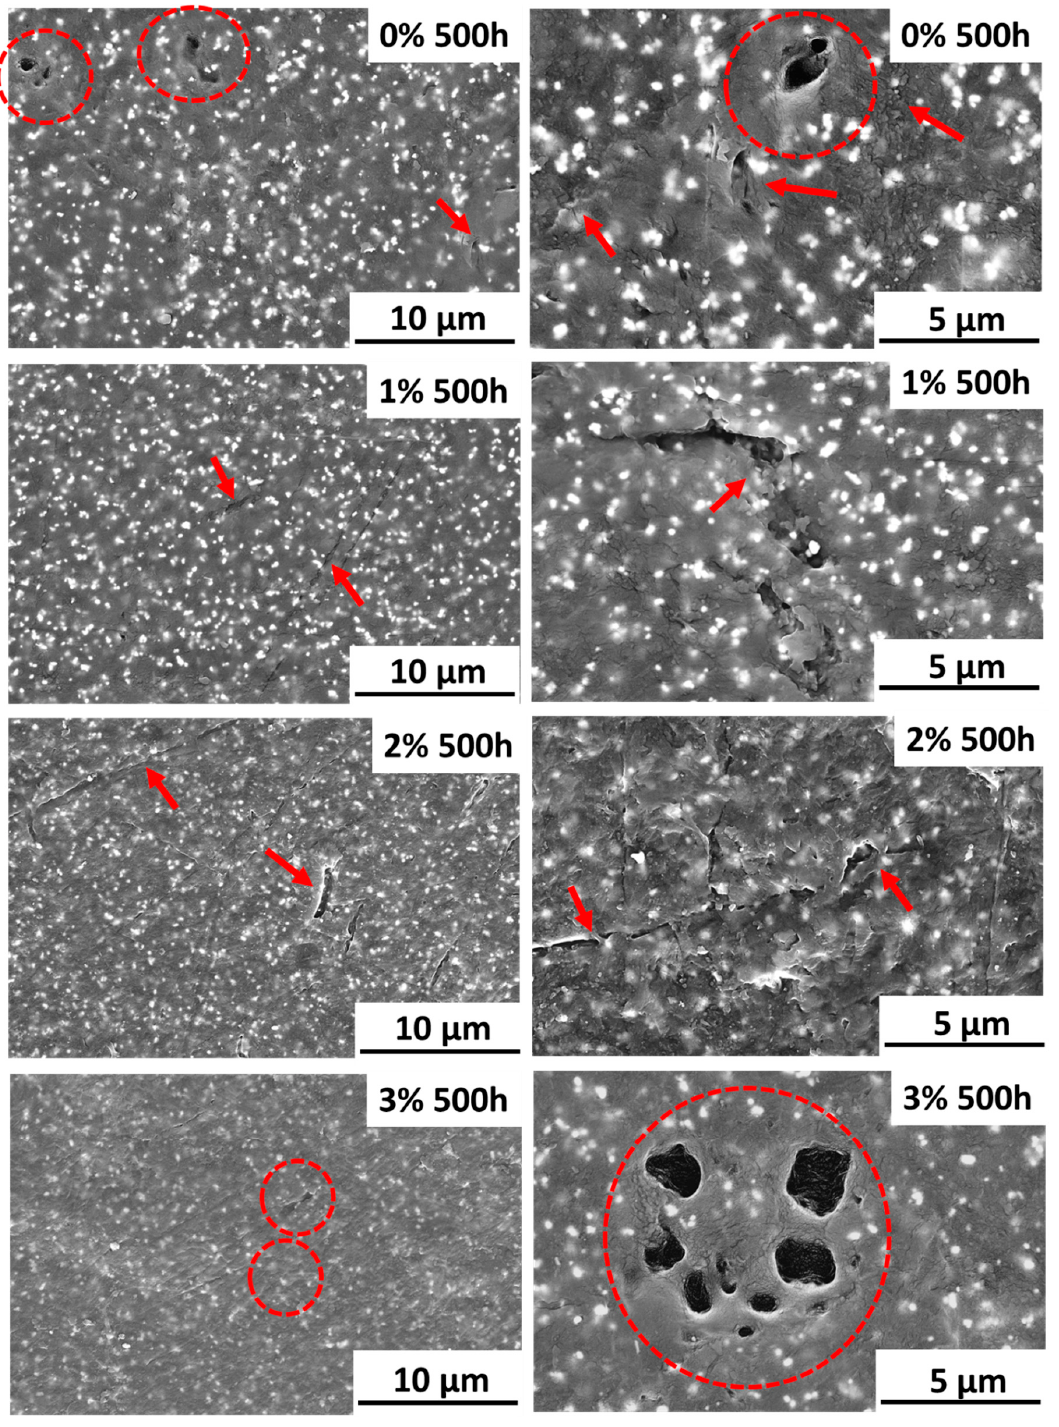
Figure 5. SEM micrographs of the surface of the organic coatings under study after xenon exposure (magnification of left images ×4000, right images ×8000).